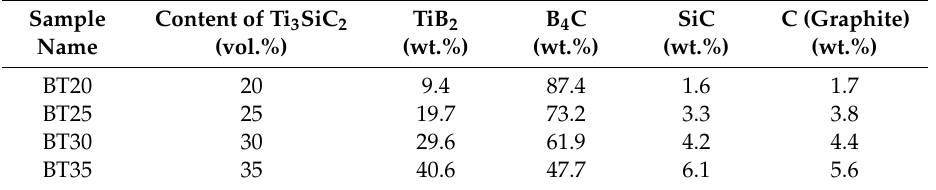
Table 1. Contents of di ff erent phases in B 4 C–TiB 2 composite ceramics sintered at di ff erent temperatures.